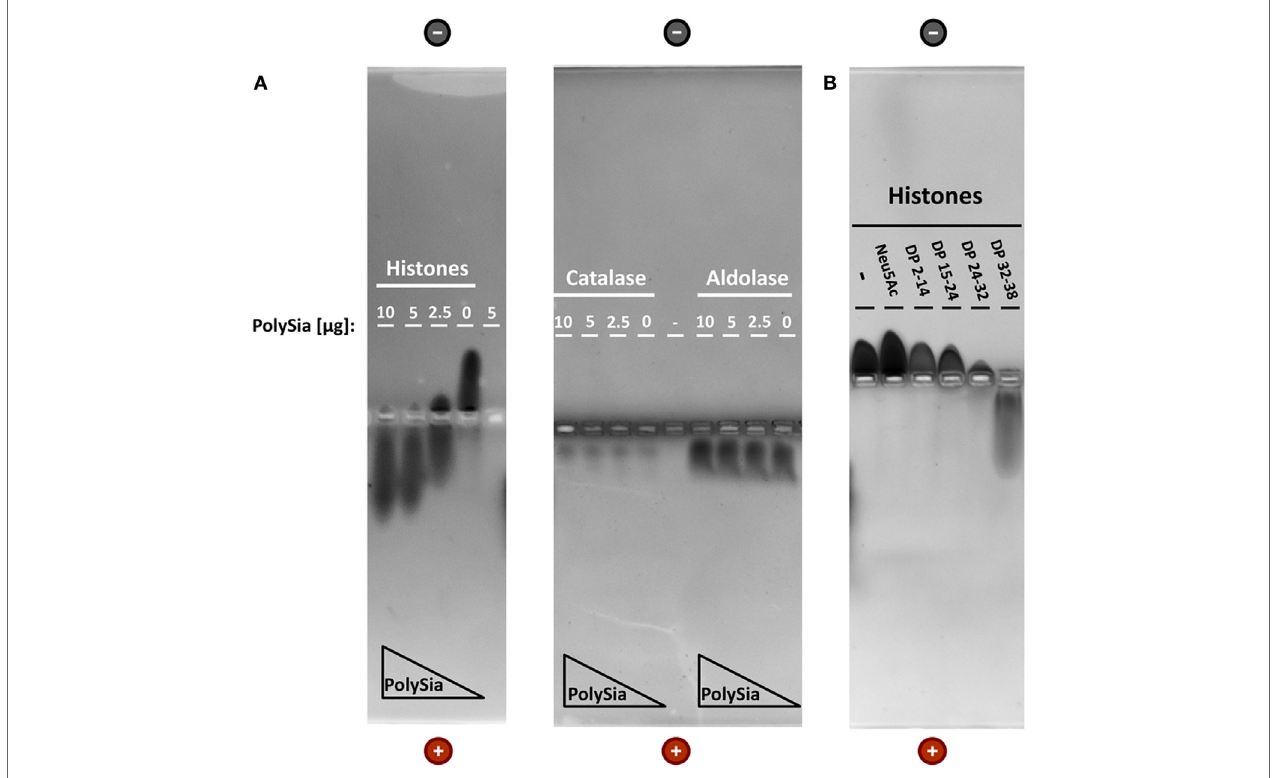
FigUre 1 | PolySia interact with histones. Non-covalent binding assays of histones and polySia were applied using native gel electrophoresis. (a) Proteins (5 µg) were preincubated with different concentrations of polySia (mixture of different chain lengths). Due to the interaction with highly negatively charged polySia chains, histones–polySia complexes migrate together to the positive pole. Catalase and aldolase were used as negative controls. (B) In addition, histones (10 µg) were incubated with altered chain lengths of polySia (all 5 µg). Proteins were stained with Coomassie